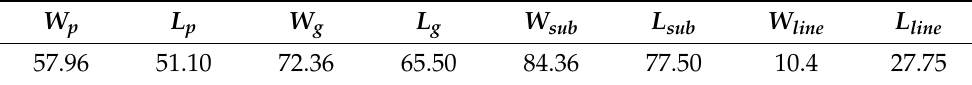
Figure 1. Perspective view of the electromagnetically coupled microstrip patch textile antenna structure. For clarity, all the antenna layers have been separated and labeled at the side. Table 2. Proposed antenna dimensions 1 .